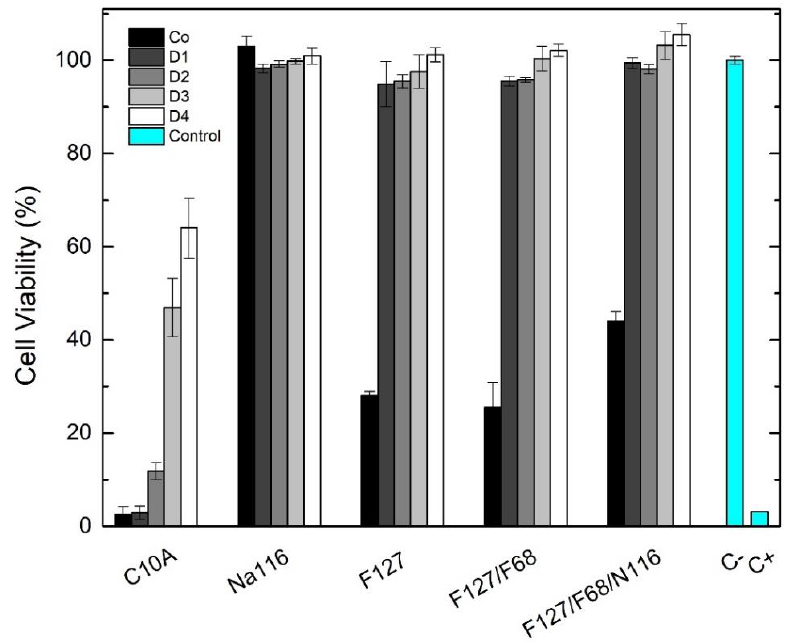
Figure 12. Vero cell viability (%) after 48 h of indirect exposure to the DDS developed. Initial extract concentrations: F127, 250 mg/mL; F127/F68, 225 mg/mL, and 25 mg/mL, respectively; for Na116, 20 mg/mL; for F127/F68/Na116 composite, 225 mg/mL, 25 mg/mL and 20 mg/mL, respectively. Extracts were prepared incubating the respective formulation with DMEM medium at 37 °C for 48 h. Data are expressed as average ± standard deviation for at least four independent experiments. C− represents the negative control (no medium alterations), and C+ represent positive control (medium with 10 µL of DMSO).